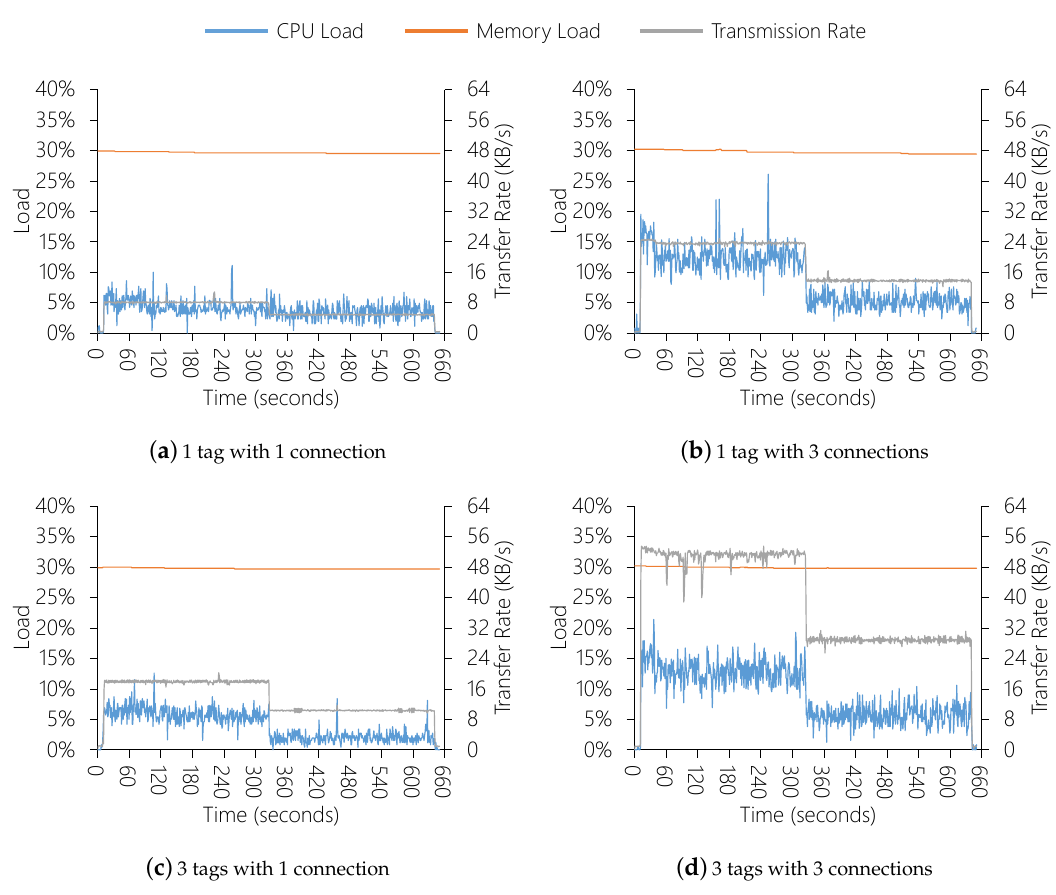
Figure 12. Results with QualiCare Manager adapting the